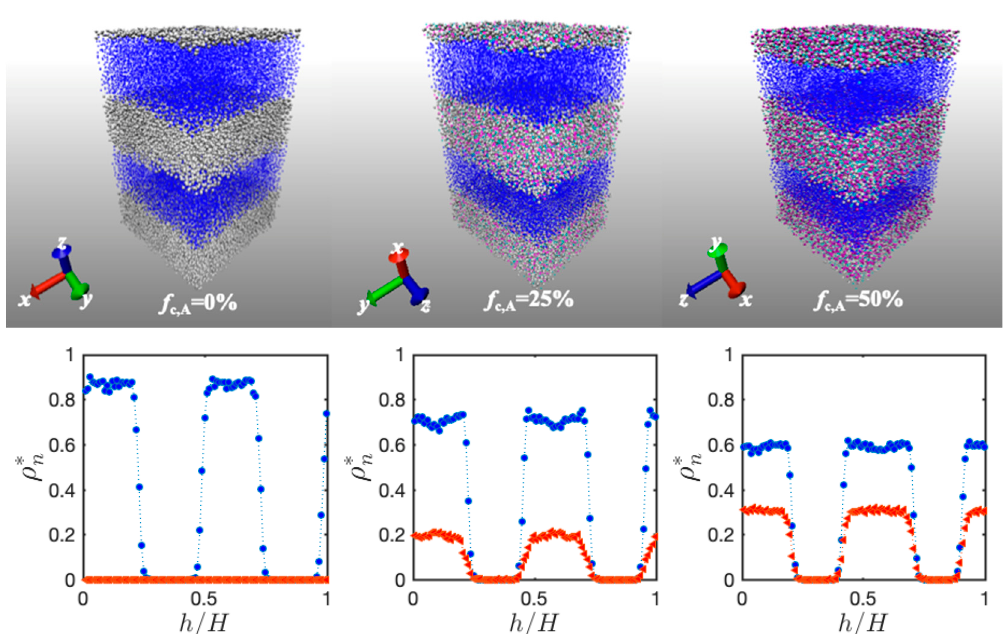
Figure 2. ( Top panel ) Morphology of lamellar ionic Block copolymers (BCPs) with varying charge ratio of A block, f c , A from 0% to 50%, where the neutral A block is in white and B block in blue, the charged A block in red and charged counterion in cyan; and ( bottom panel ) number distribution of A block monomer and charged counterions along the height of the simulation box of the corresponding systems equilibrated at T * = 1.0 .